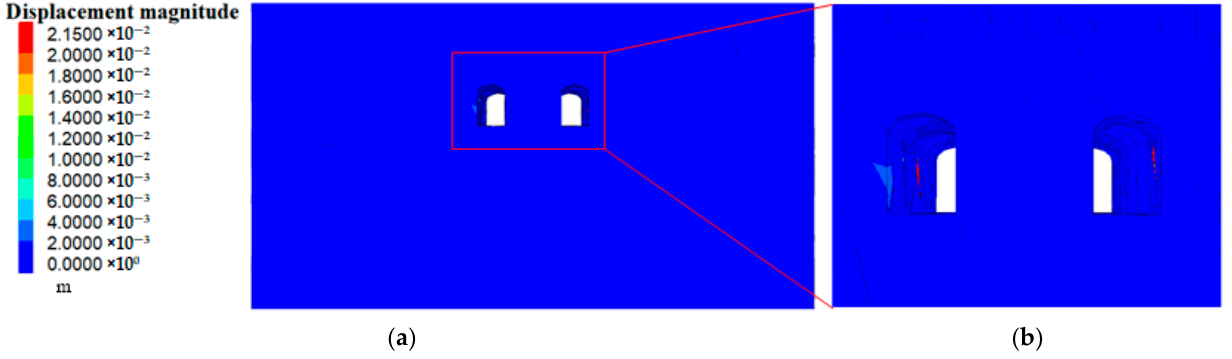
Figure 20. Displacement contours of surrounding rock of cavern: ( a ) Displacement of the study area, ( b ) Magnified displacement of surrounding rock (7 MPa).